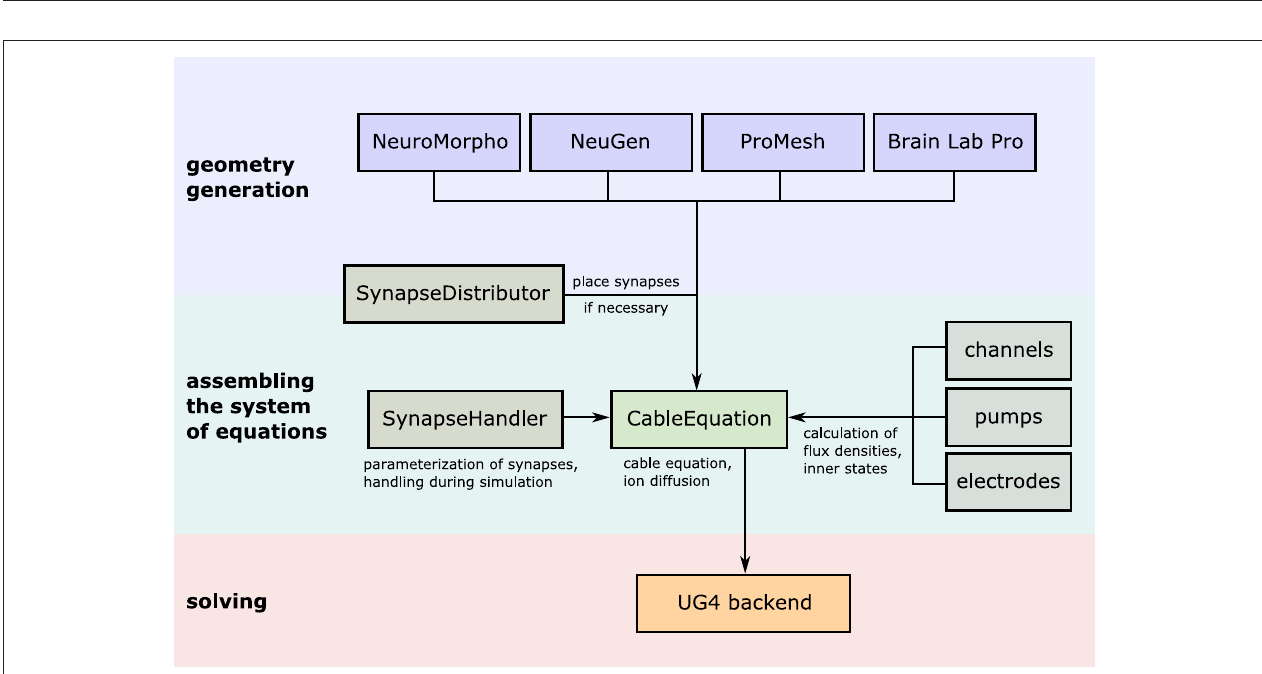
FIGURE 4 | Sketch of the NeuroBox framework, using an ion channel model as an example. Functionality of the channel is implemented in a C deriving from a pre-defined interface. The implementation can be automatically generated by conversion from NMODL model file. Registering the class at the UG 4 registry and compiling makes the channel available for usage in simulations defined either by a Lua script or by a graphical workflow representation using VRL-Studio.